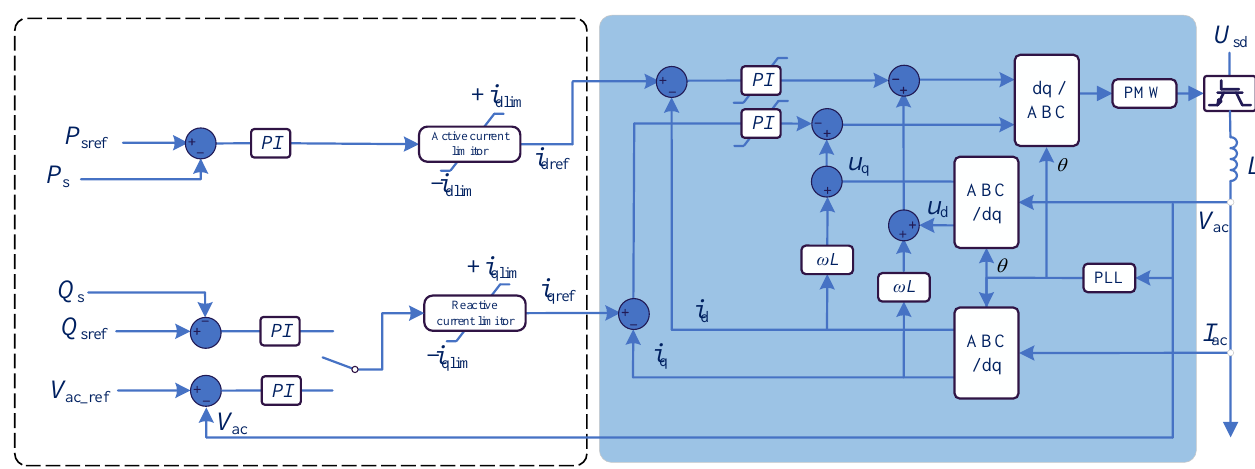
Figure 2. The control strategies of mainly controlled converter in IPFC.